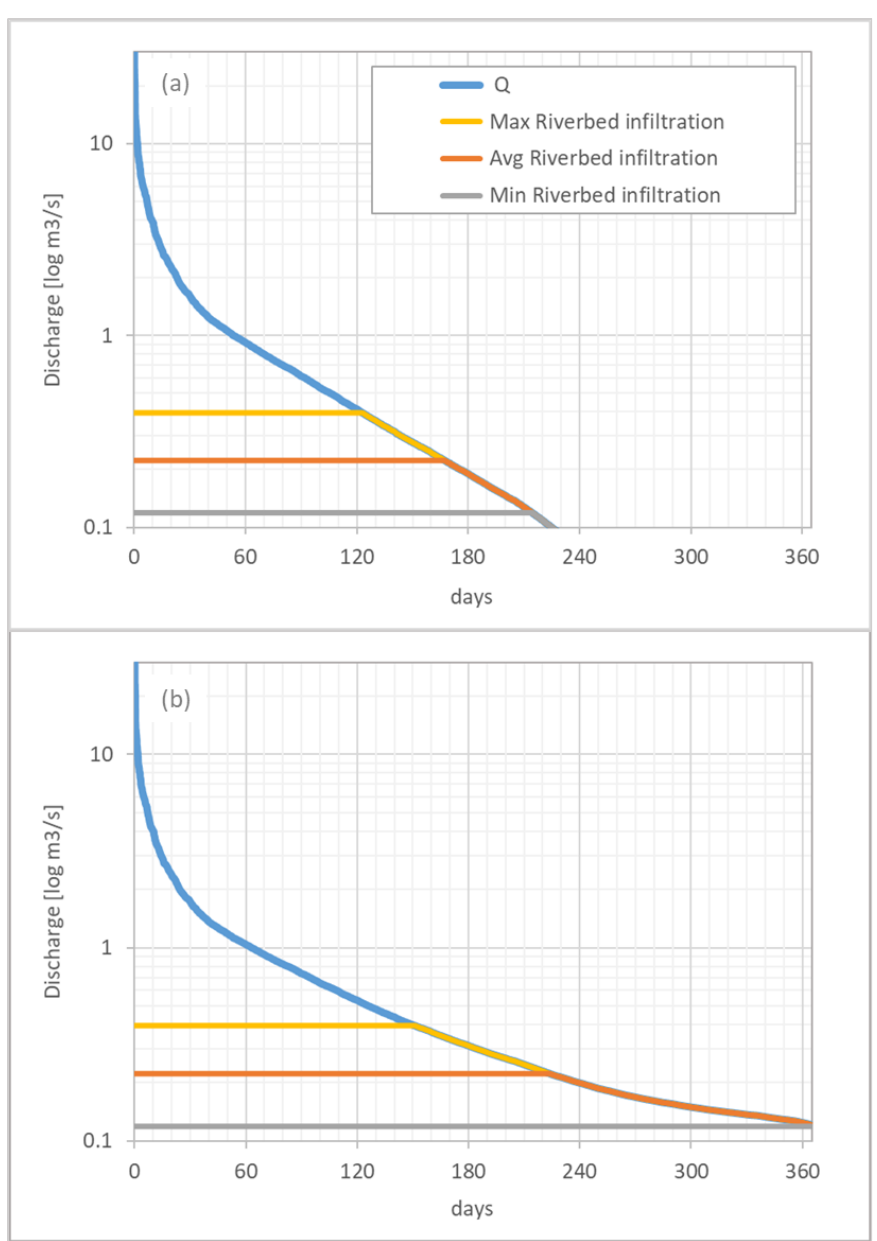
Figure 6. Flow (blue line) and transmission loss duration curves (yellow, orange and grey) of the Canale Reale River. ( a ) scenario #1: Q = simulated rainfall-runoff, ( b ) scenario #2: Q = daily discharge from the four WWTPs outlets summed to the simulated rainfall-runoff.